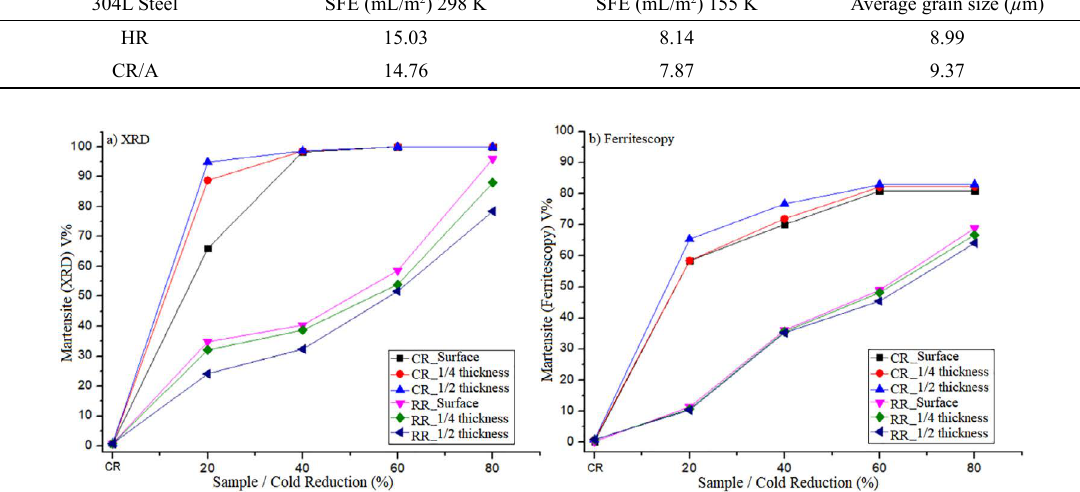
Figure 2. Induced martensitic transformation by rolling at 298 K (RR) and 155 K (CR). Analyses performed on whole, 3 4 and 1 2 samples.